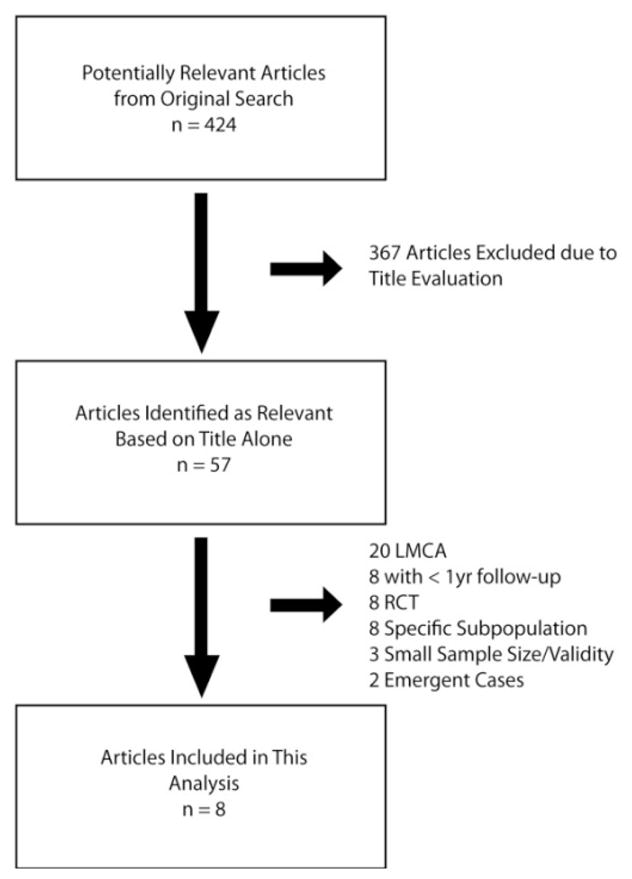
SearchcriteriaLMCA=left main coronary artery; RCT=randomized controlled trial.